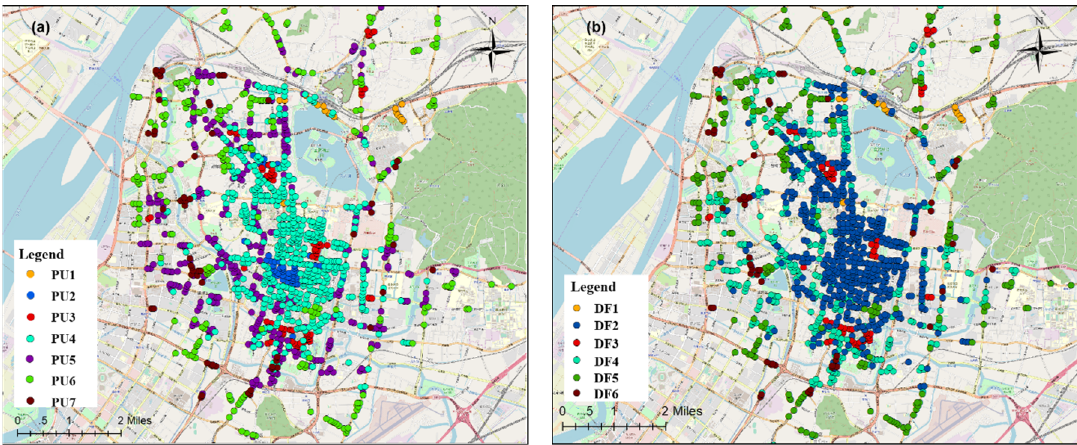
Figure 10. Spatial distribution map of the departure and arrival patterns on weekdays. PU, Pick-Up. DF, Drop-Off.